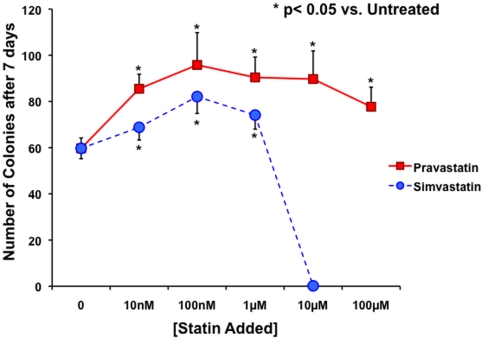
In Vitro Pravastatin and Simvastatin Promotes Growth of LOEPCs under Clonogenic Conditions.LOEPC cell lines from pigs were plated under limiting dilution conditions in the absence or presence of pravastatin or simvastatin. The number of LOEPCs was determined after seven days of growth with or without statin. The data are presented as the means ± SEM from eight independent experiments.